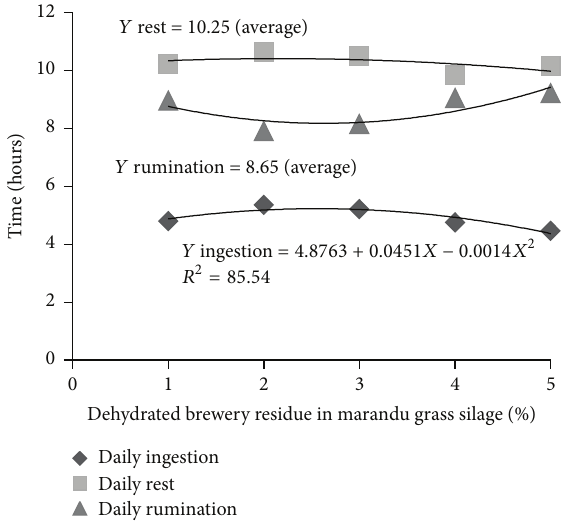
Figure 1: Ingestion time, rest, and rumination in hours, during the daily period (24 hours) of ovine fed with marandu grass silage.